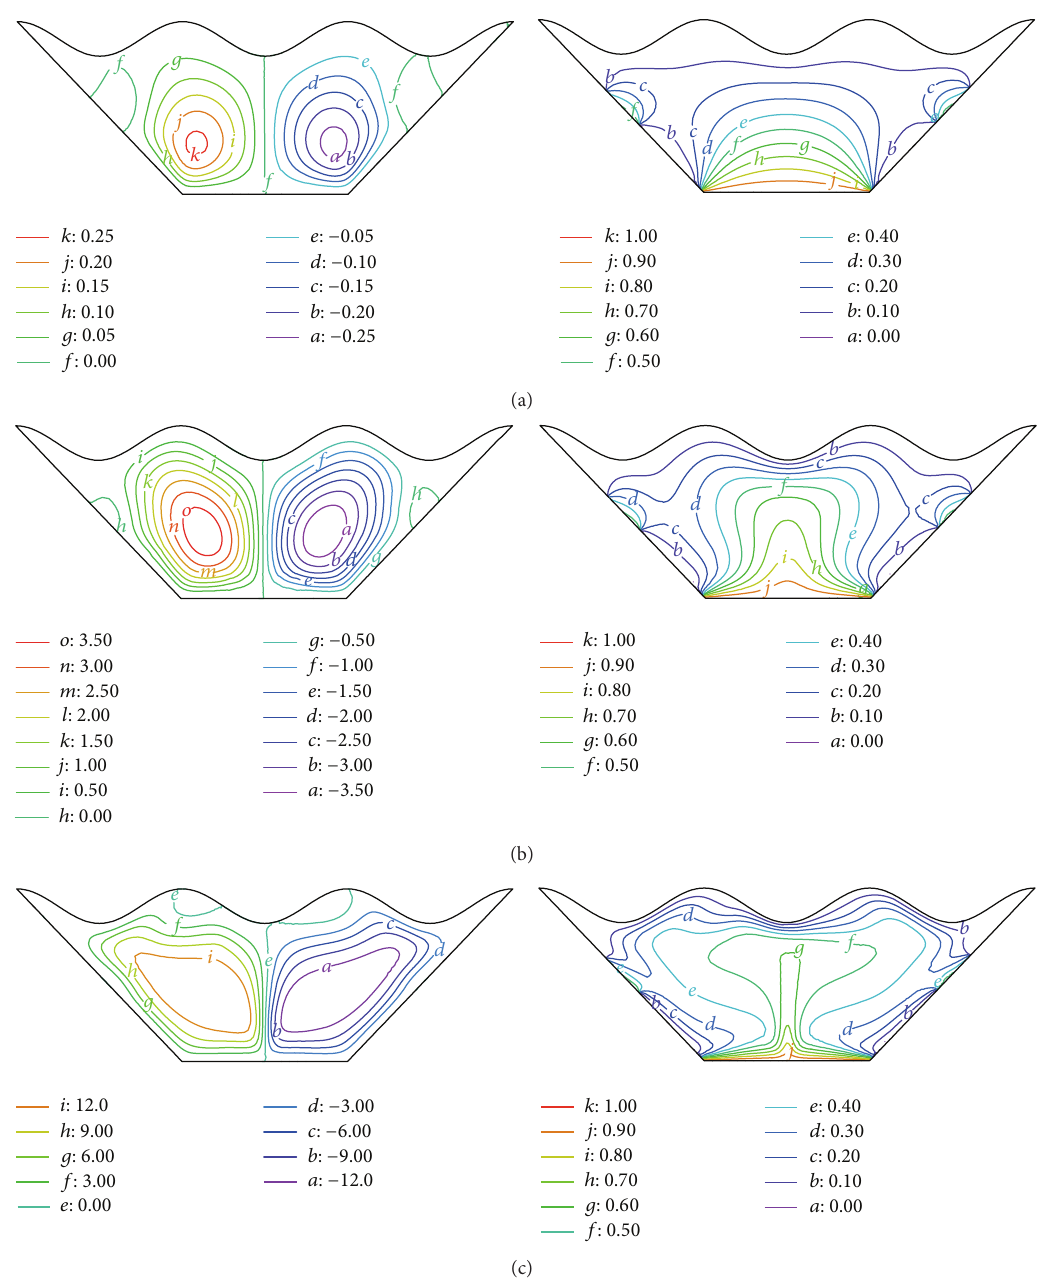
Figure 2: Streamlines (left) and isotherms (right) for Da = 10 −3 and 𝑎 = 0.9 . (a) Ra = 10 4 , (b) Ra = 10 5 , and (c) Ra = 10 6 .